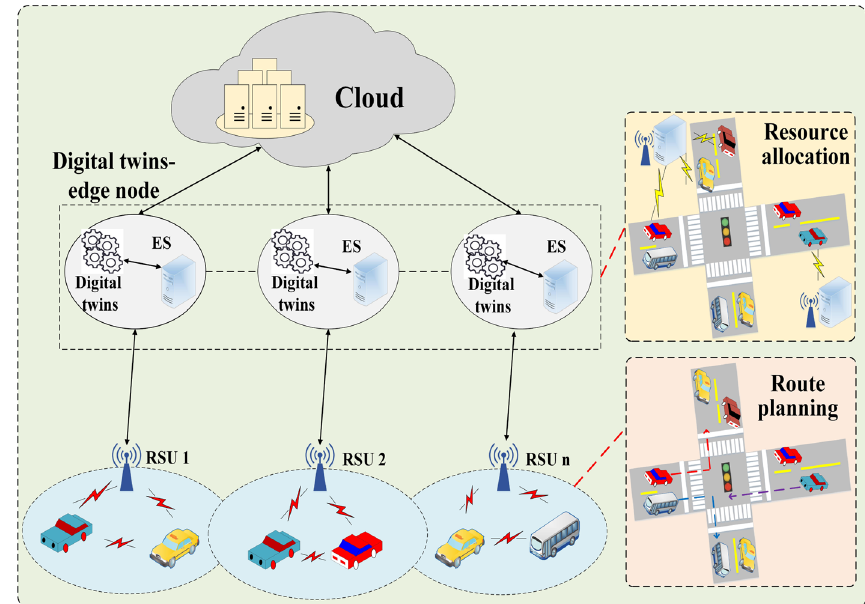
Fig. 1 CVs system framework based on